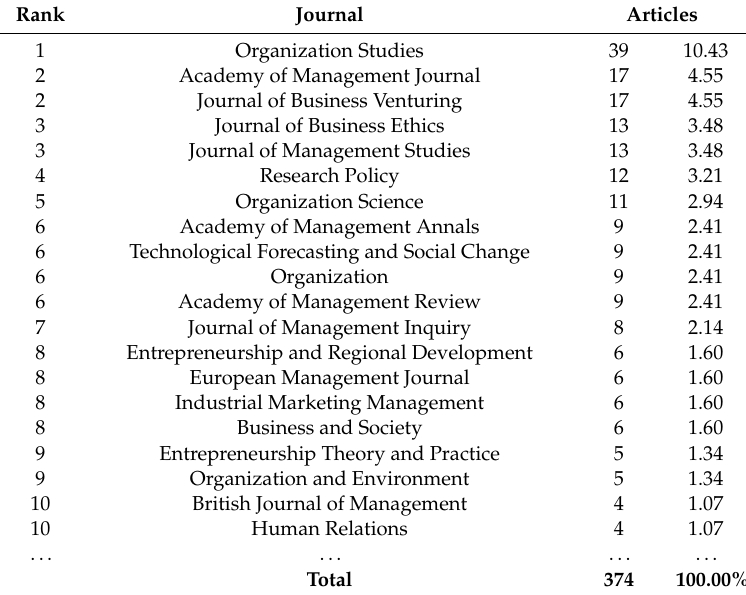
Table 3. Journal productivity.